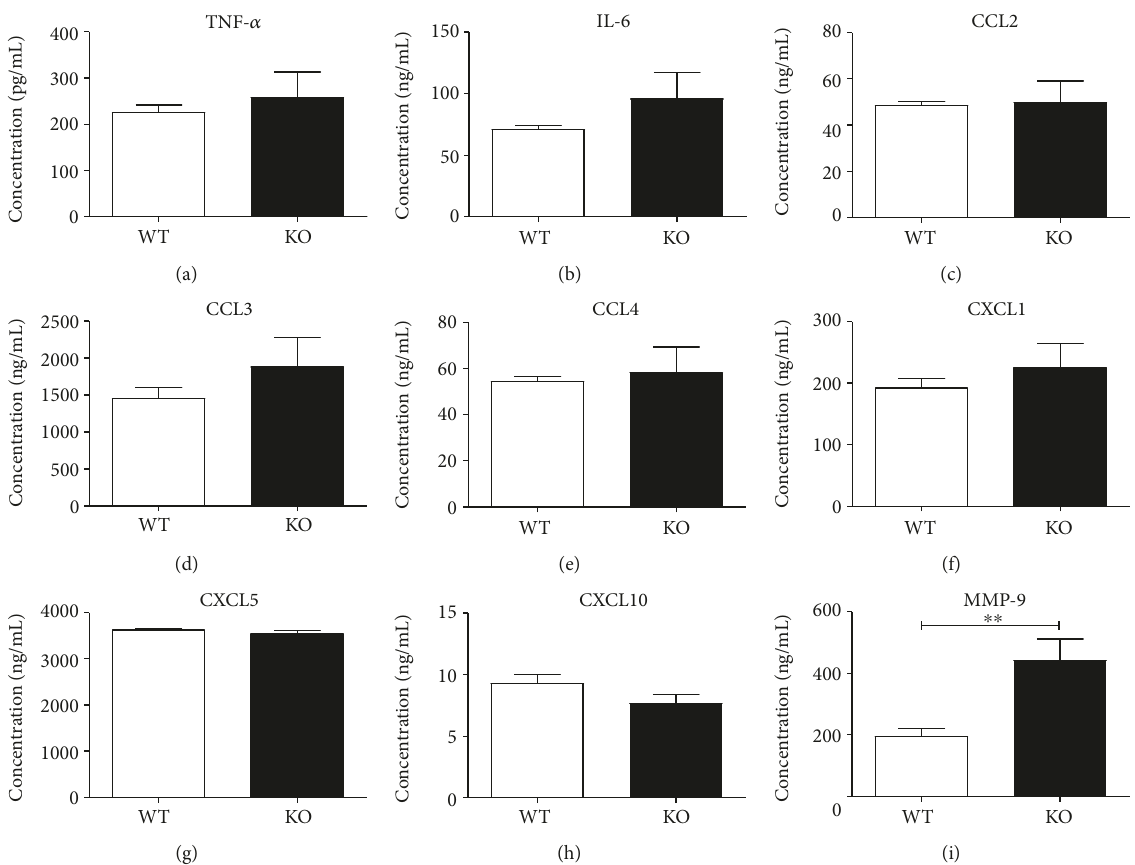
Figure 3: CB de fi ciency results in higher MMP-9 levels in the serum of endotoxemic mice. Male C57BL/6J and CB 2 weeks old) were administered i.p. with 1 mg/kg LPS and the levels of proin fl ammatory mediators in the serum at 2 hours was measured. The levels of TNF- α (a), IL-6 (b), CCL2 (c), CCL3 (d), CCL4 (e), CXCL1 (f), CXCL5 (g), CXCL10 (h), and MMP-9 (i) were measured in serum samples by Luminex. Data are from two independent experiments with 6 – 9 mice per group and 3 – 5 mice per group per experiment. Mean +SEM are represented in all bar graphs and data were analysed with a one-tailed student t -test, ∗∗ p < 0 01